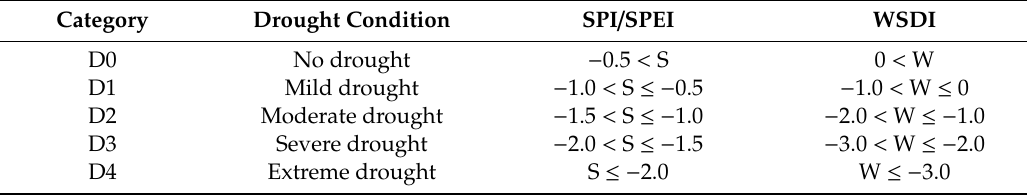
Table 1. Drought severity category based on drought indices. SPI: standardized precipitation index; SPEI: standardized precipitation evapotranspiration